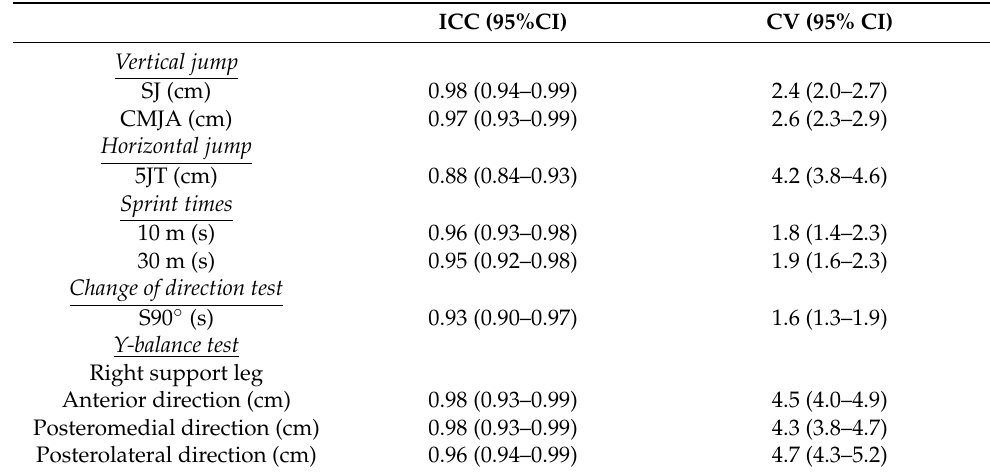
Table 3. Interclass correlation coefficient (ICC, 95% confidence intervals (CI)) and coefficient of variation (CV) for all fitness